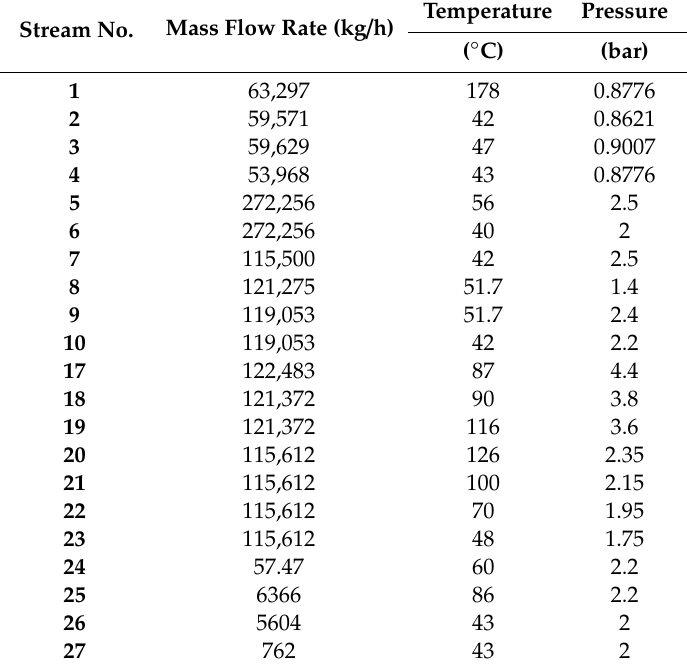
Table 3. Operation conditions of the